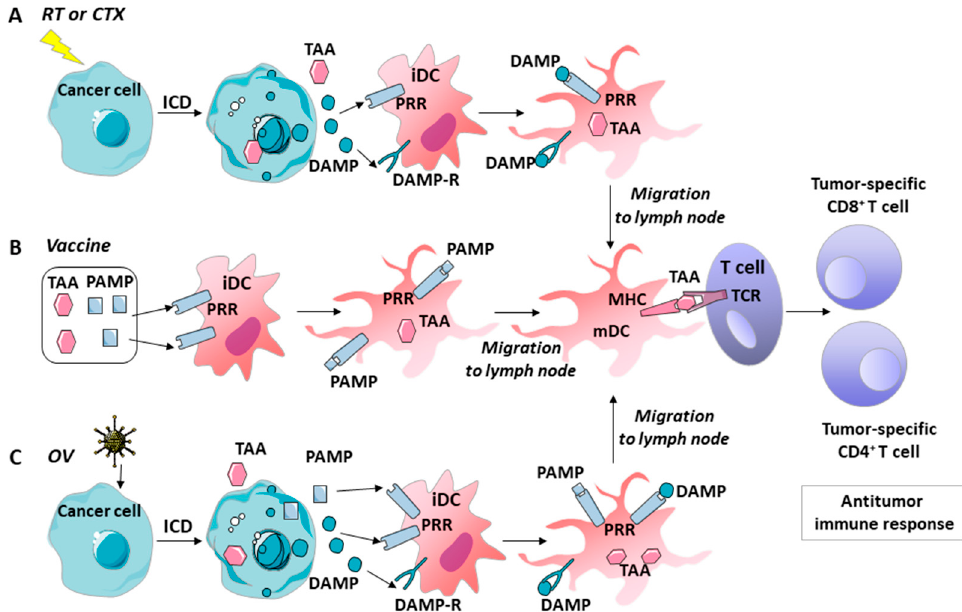
Figure 2. Activation of the antitumor immune response under various tumor therapies. ( A ) Radio- therapy or chemotherapy can be used to induce ICD in cancer cells. ICD results in the release of TAA and DAMPs in the tumor microenvironment. DAMPs are then recognized by PRRs and the DAMP receptors of tumor-resident immature DCs, which activates TAA uptake by DCs, DC maturation, and the presentation of TAA–MHC complexes. Then, DCs migrate to the lymph nodes to present TAA to immature effector T cells. Finally, the activated CD8+ and CD4+ effector T cells mediate the antitumor immune response. ( B ) A cancer vaccine was produced using a cocktail of TAA and foreign antigens. When vaccinated, foreign antigens act as PAMPs. These antigens provide danger signals to enable recognition of the vaccine by the PRRs of DCs, uptake of the vaccine TAA by DCs, and maturation of the DCs and their migration to the lymph nodes. Finally, activated CD8+ and CD4+ effector T cells mediate the antitumor immune response. ( C ) An oncolytic virus can in- duce ICD in cancer cells. ICD results in the release of TAA, as well as viral PAMPs and DAMPs in the tumor microenvironment. PAMPs and DAMPs are recognized by PRRs and the DAMP recep- tors of tumor-resident immature DCs, which activates the uptake of TAA by DCs, DC maturation, the presentation of TAA-MHC complexes, and migration to the lymph nodes. Finally, activated CD8+ and CD4+ effector T cells mediate the antitumor immune response. ICD, immunogenic cell death; TAA, tumor-associated antigens; DAMP, damage-associated molecular pattern; PAMP, path- ogen-associated molecular pattern; PRRs, pattern-recognition receptors; DAMP-R, DAMP receptor; iDC, immature dendritic cell; mDC, mature dendritic cell; TCR, T cell receptor; RT, radiotherapy; CTX, chemotherapy; OV, oncolytic virus. The first oncolytic virus approved by the FDA for the treatment of cutaneous and subcutaneous melanoma was T-VEC (in 2015). T-VEC (Talimogene laherparepvec; Imlyg- icTM) is a genetically modified herpes simplex virus (type 1) engineered to express GM– CSF and provides great information on the efficiency and safety of OV applications in clinic. The effect of T-VEC is attenuated by the deletion of herpes neurovirulence viral genes enhanced for immunogenicity by the deletion of the viral ICP47 gene. Immunogen- icity is supported by expression of the GM–CSF gene. T-VEC yielded a significant im- provement in the durable response rate, objective response rate, and progression-free sur- vival in a randomized phase III clinical trial for patients with advanced melanoma [75,118–120]. Relative to GM–CSF, T-VEC significantly increased the durable response rate (16.3 vs. 2.1%, p < 0.001). However, the median overall survival was improved only